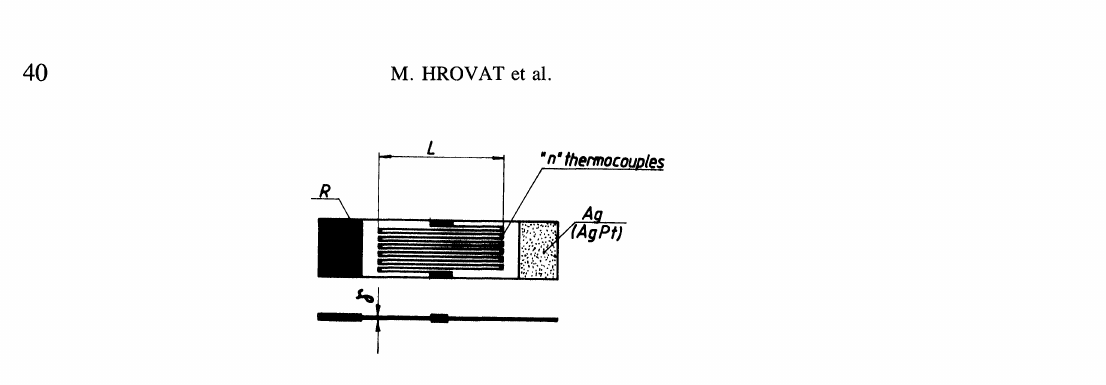
FIGURE An experimental prototype of a thick film sensing element for RMS meter. On one side of the A1203 substrate is the heating resistor, the other side is metallized with Ag/Pt or Ag/Pd conductor for soldering it into a heat sink. The output voltage U is generated by the temperature difference between the hot and cold junction.